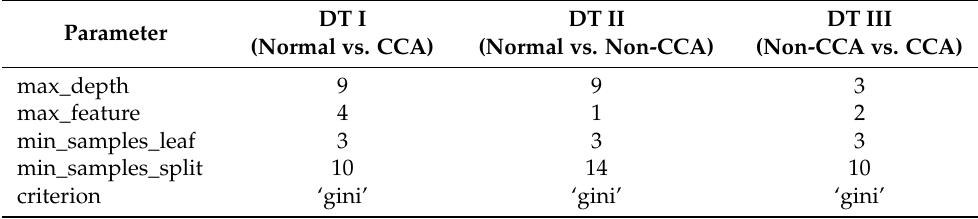
Table 5. The best tree’s parameters for each decision tree (DT) model after performing five-fold cross validation method with GridSearchCV criterion.